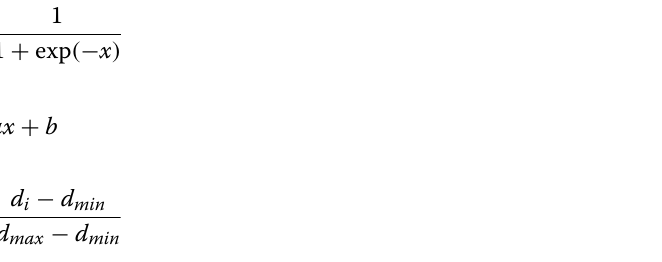
Table 1 Experimental levels of the selected parameters Factors Levels 1 2 3 Tool concentration High ( H ) (100%) Normal ( N ) (50%) Spindle speed (rpm) 3000 5000 7000 8000 Feed rate